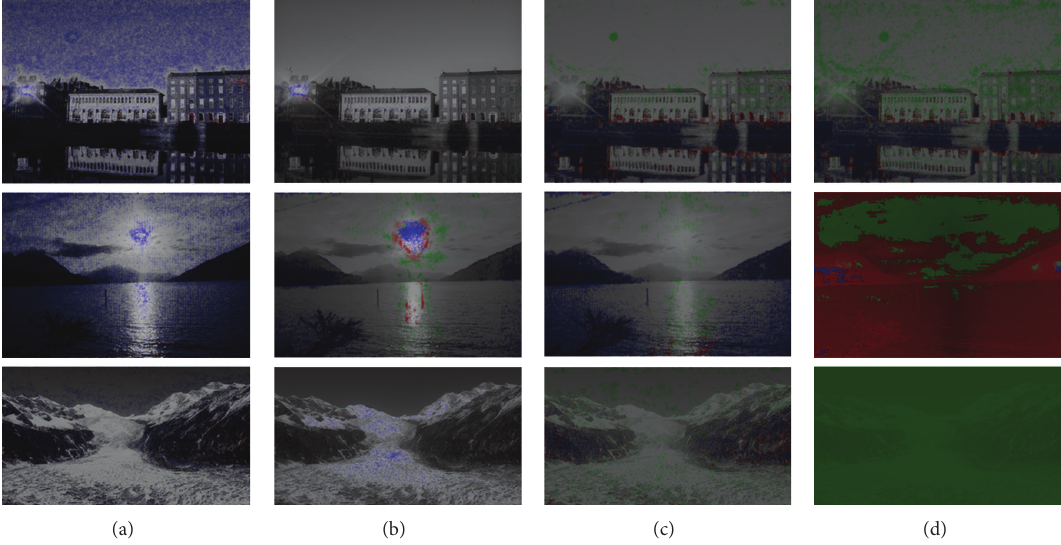
Figure 2: The result images from the metric of Aydin et al. [12]. The original images are building, sun, and snow in Figure 1, (a) proposed, (b) iPG, (c) LDR2HDR, (d) 𝛾 expansion. Red, green, and blue identify contrast reversal, loss of visible contrast, and amplification of invisible contrast,